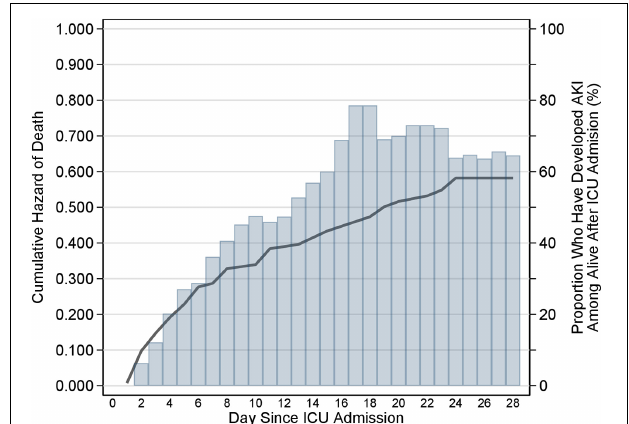
FIGURE 2 | Cumulative hazard of death and cumulative incidence of AKI during ICU stay. Cumulative hazard of death (solid line) and cumulative incidence of AKI (histogram) during the 28-day follow-up in the ICU. The hazard of death and the incidence of AKI is the daily risk of dying and developing AKI, respectively. The graph represents the cumulative sum of each of the two rates. If the cumulative hazard of death is constant over time in the ICU, then the cumulative hazard will rise linearly with days since admission in the ICU ( x -axis); if the hazard increases with time in the ICU, the cumulative hazard will rise non-linearly showing an increase in slope with increasing days since admission; if the hazard decreases with time in the ICU the cumulative hazard will still rise, but now with a decrease in the slope. The same applies to the cumulative incidence of AKI. The graph shows that both the hazard of death and the incidence of AKI tended to decrease after the first 8 days after ICU admission. AKI, acute kidney injury; ICU, intensive care